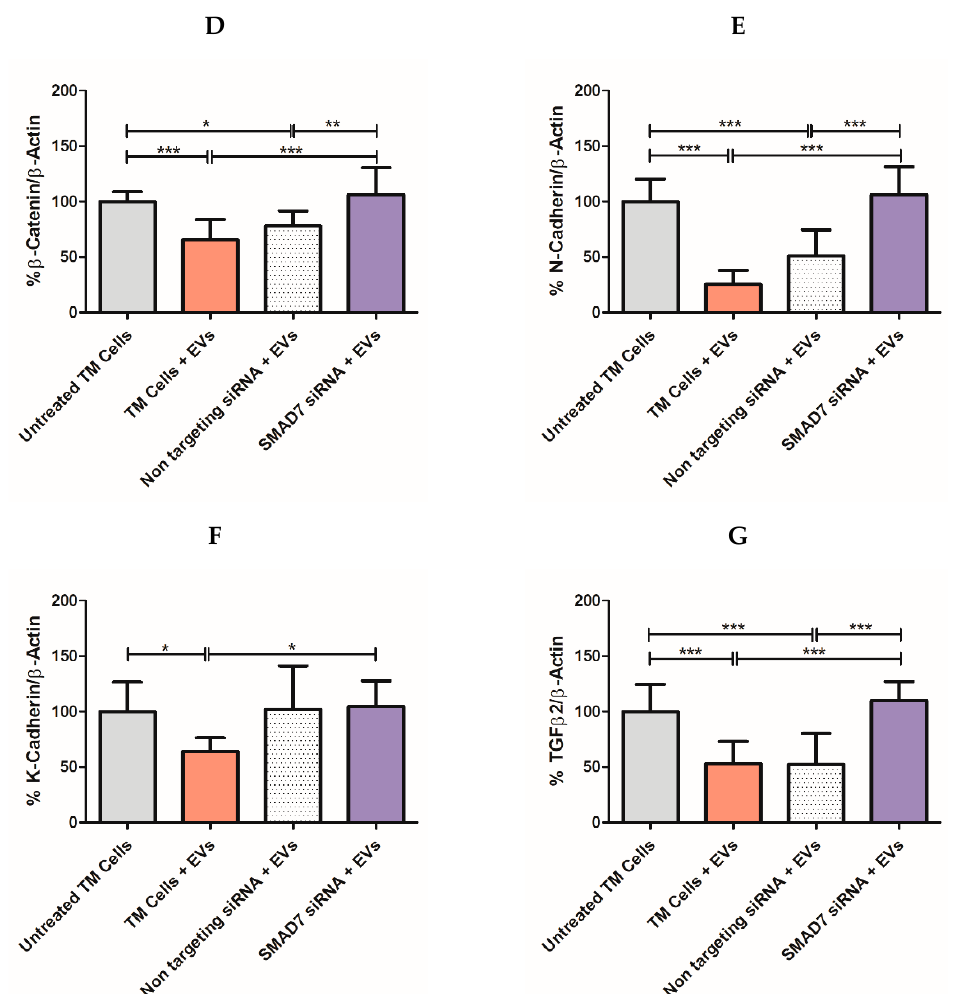
Figure 6. Expression of Wnt-TGF β 2 signaling proteins in TM cells following treatment with NPCE EVs loaded with siRNA. Representative Immunoblots of ( A ) N-Cadherin (138KDa), β -Catenin (90 KDa), K-Cadherin (88KDa), GSK3 β (47KDa), p-GSK3 β (45 KDa), and TGF β 2 (25KDa) proteins levels normalized to β -Actin (42 KDa) after 24 h incubation of electroporated NPCE EVs with TM cells. The bar graphs of N-Cadherin ( E ), β -Catenin ( B ), K-Cadherin ( F ), GSK3 β ( D ), p-GSK3 β ( C ), and TGF β 2 ( G ) represent the means ± SD from three independent experiments performed in triplicates. One-way ANOVA was used to determine statistical difference, as indicated by asterisks (* p < 0.05, ** p < 0.01, *** p < 0.001).